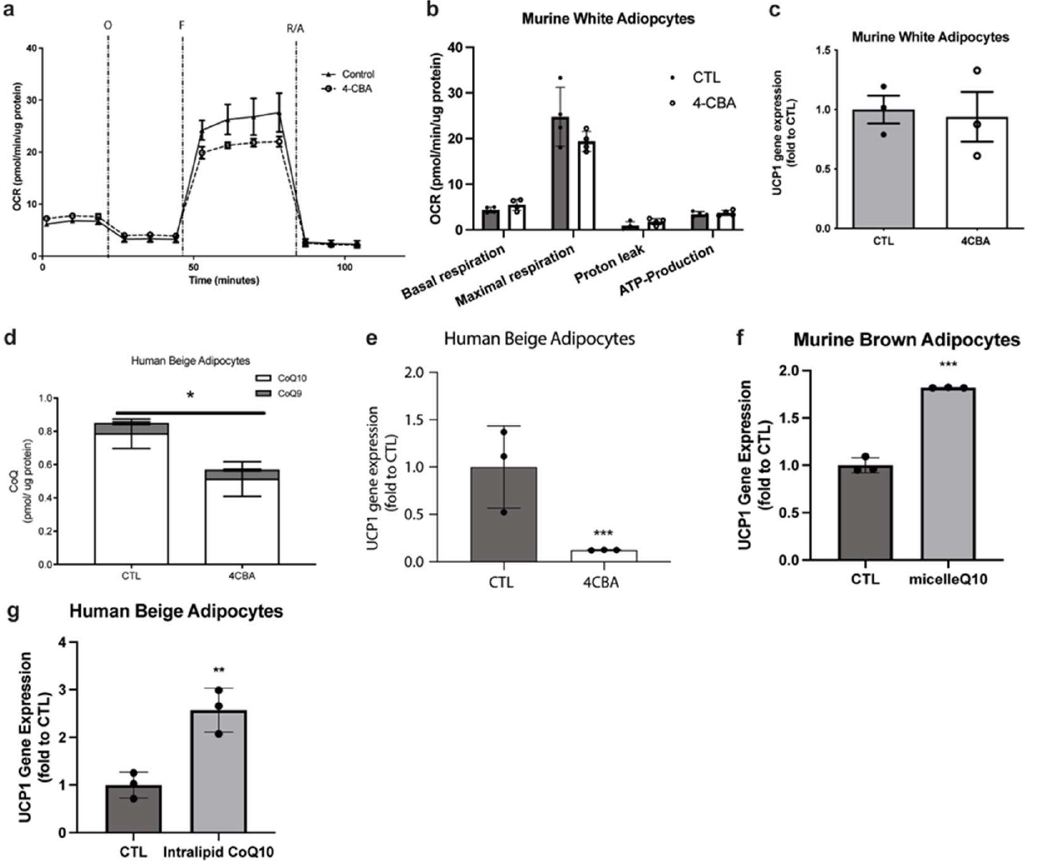
Figure 2. CoQ deficiency does not affect white adipocyte respiration and UCP1 levels. CoQ supple- mentation restores UCP1 levels in murine brown adipocytes and human beige adipocytes. ( a , b )